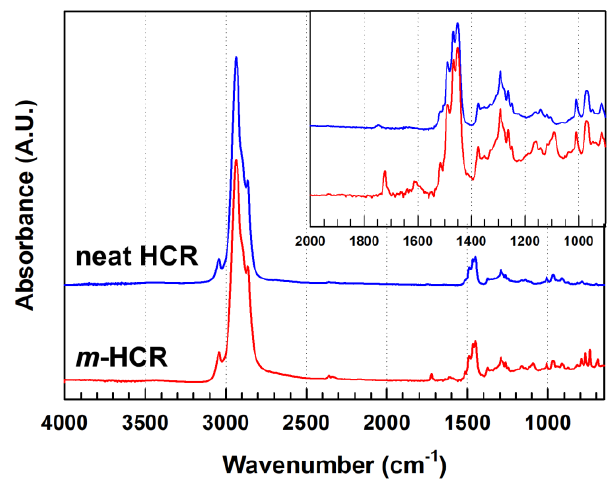
Figure 1. FT-IR spectra of neat HCR and m -HCR.